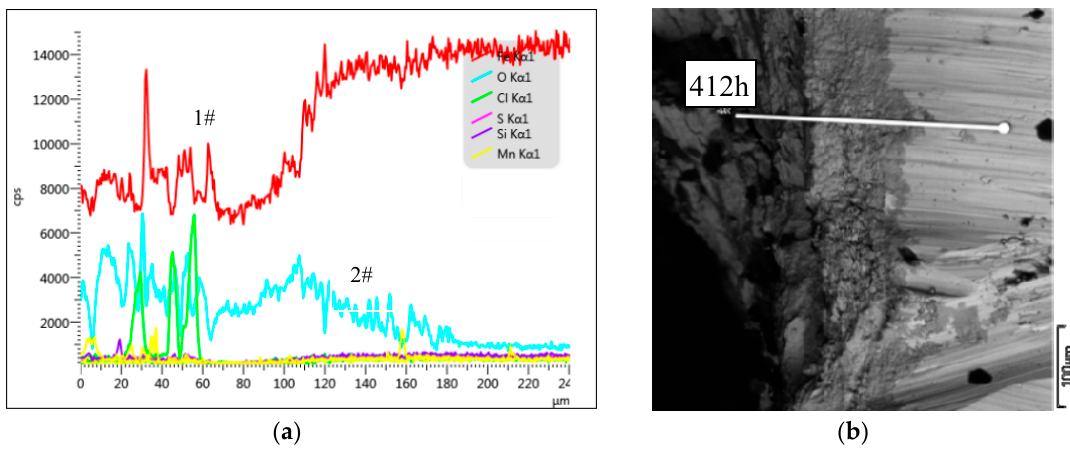
Figure 8. Group P10 line scan results. ( a ) The structure of steel corrosion products; ( b ) Micro-structure of corroded steel bars.